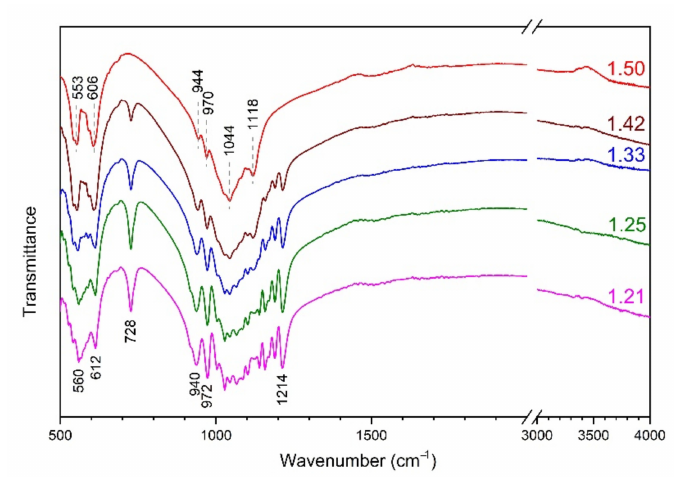
Figure 10. FTIR spectra of samples with different Ca/P ratios after